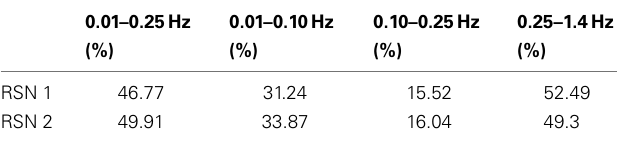
Table 1 | Fractional amplitude of fluctuations in various frequency